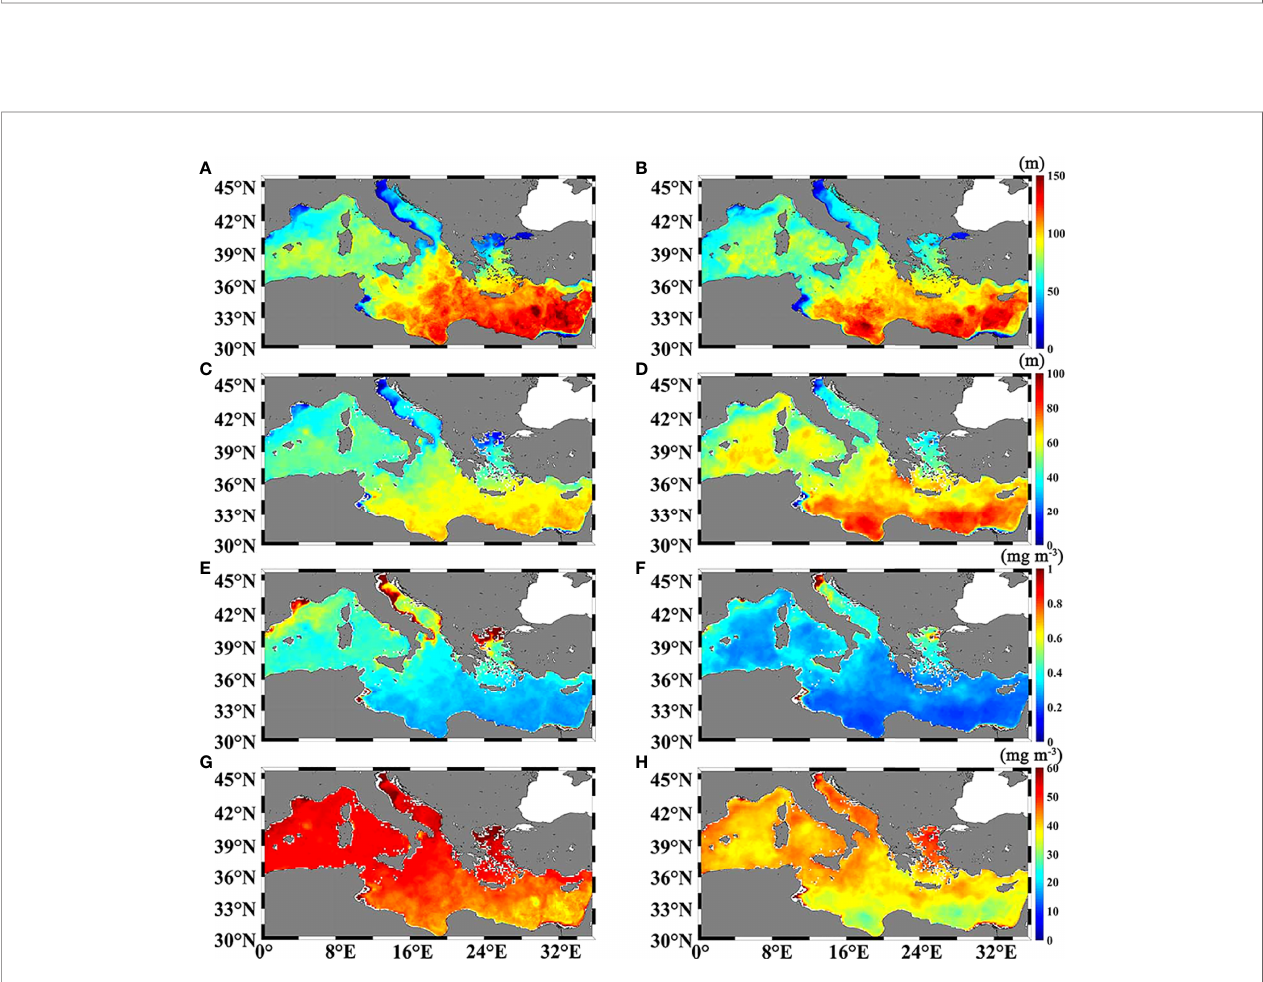
FIGURE 14 | Monthly Chl-a vertical pro fi le reconstruction results for June and September via OCRS. Panels (A) , (C) , (E) and (G) show z max , width , chl max and the Chl-a total concentration in June, respectively. Panels (B) , (D) , (F) and (H) show these parameters in